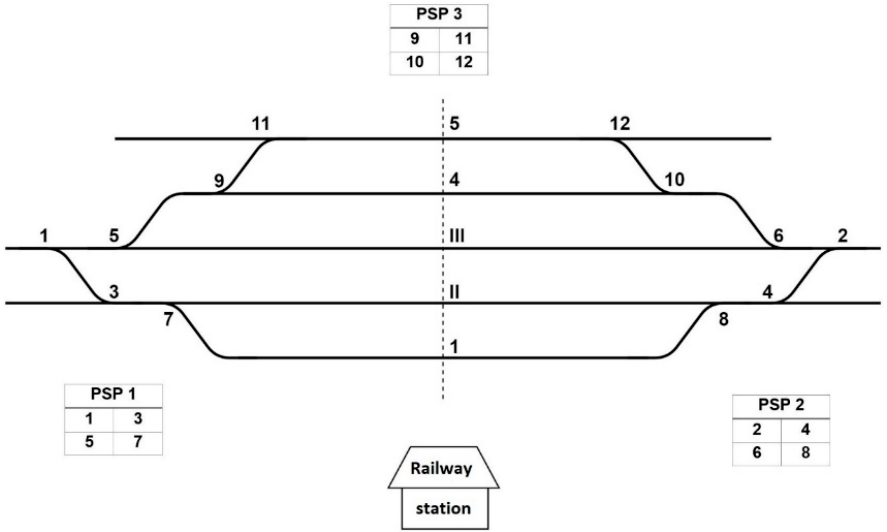
Figure 2. Schematic of a double-track railway station, switch position, and heater power supply position on the panels. PSP = power supply panel.